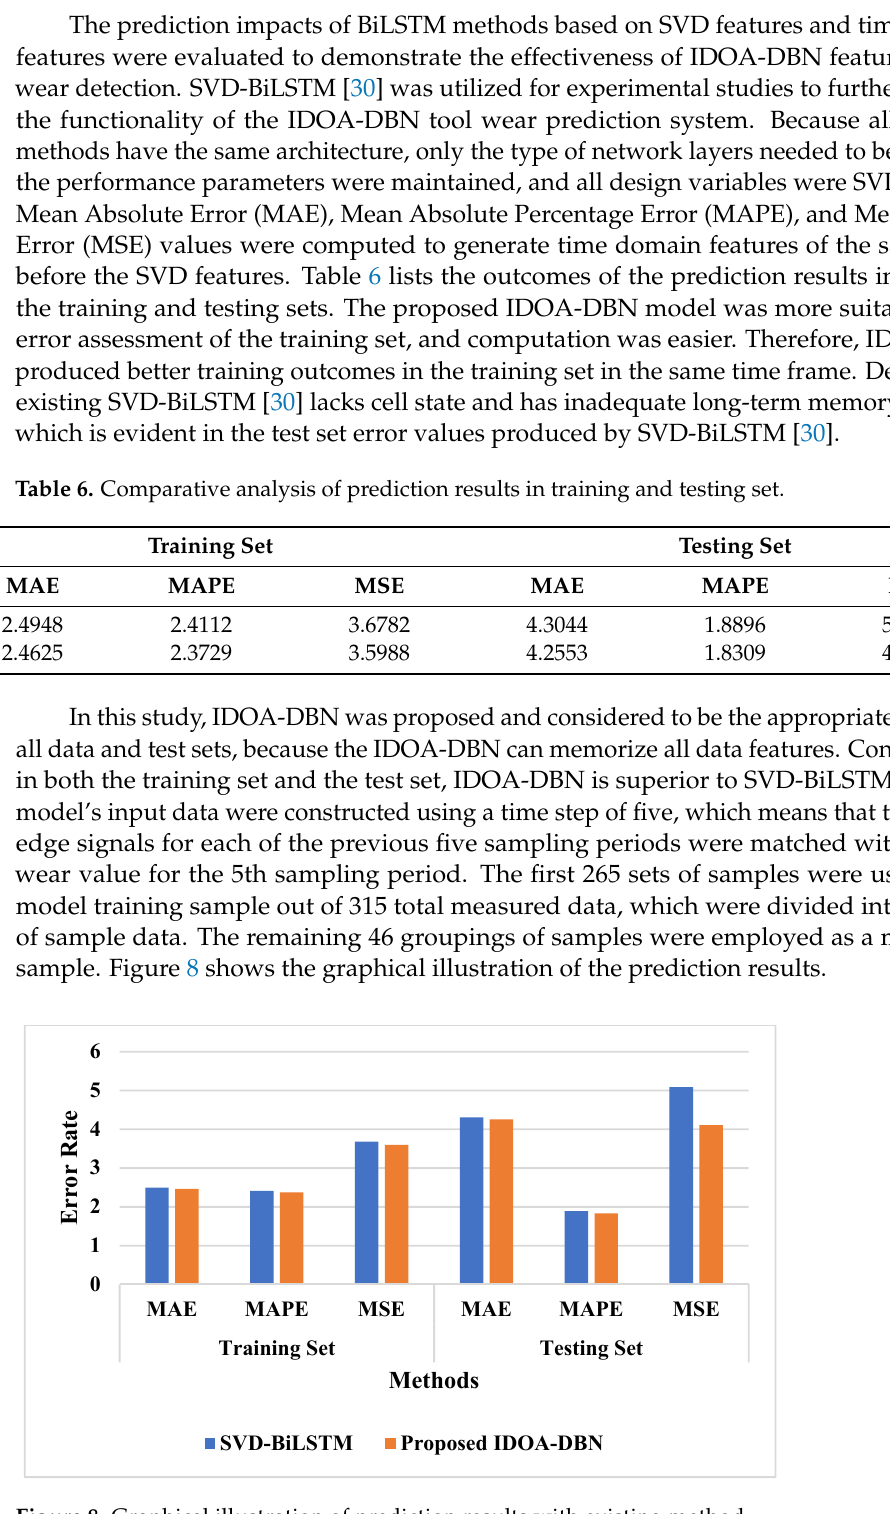
Figure 8. Graphical illustration of prediction results with existing method.